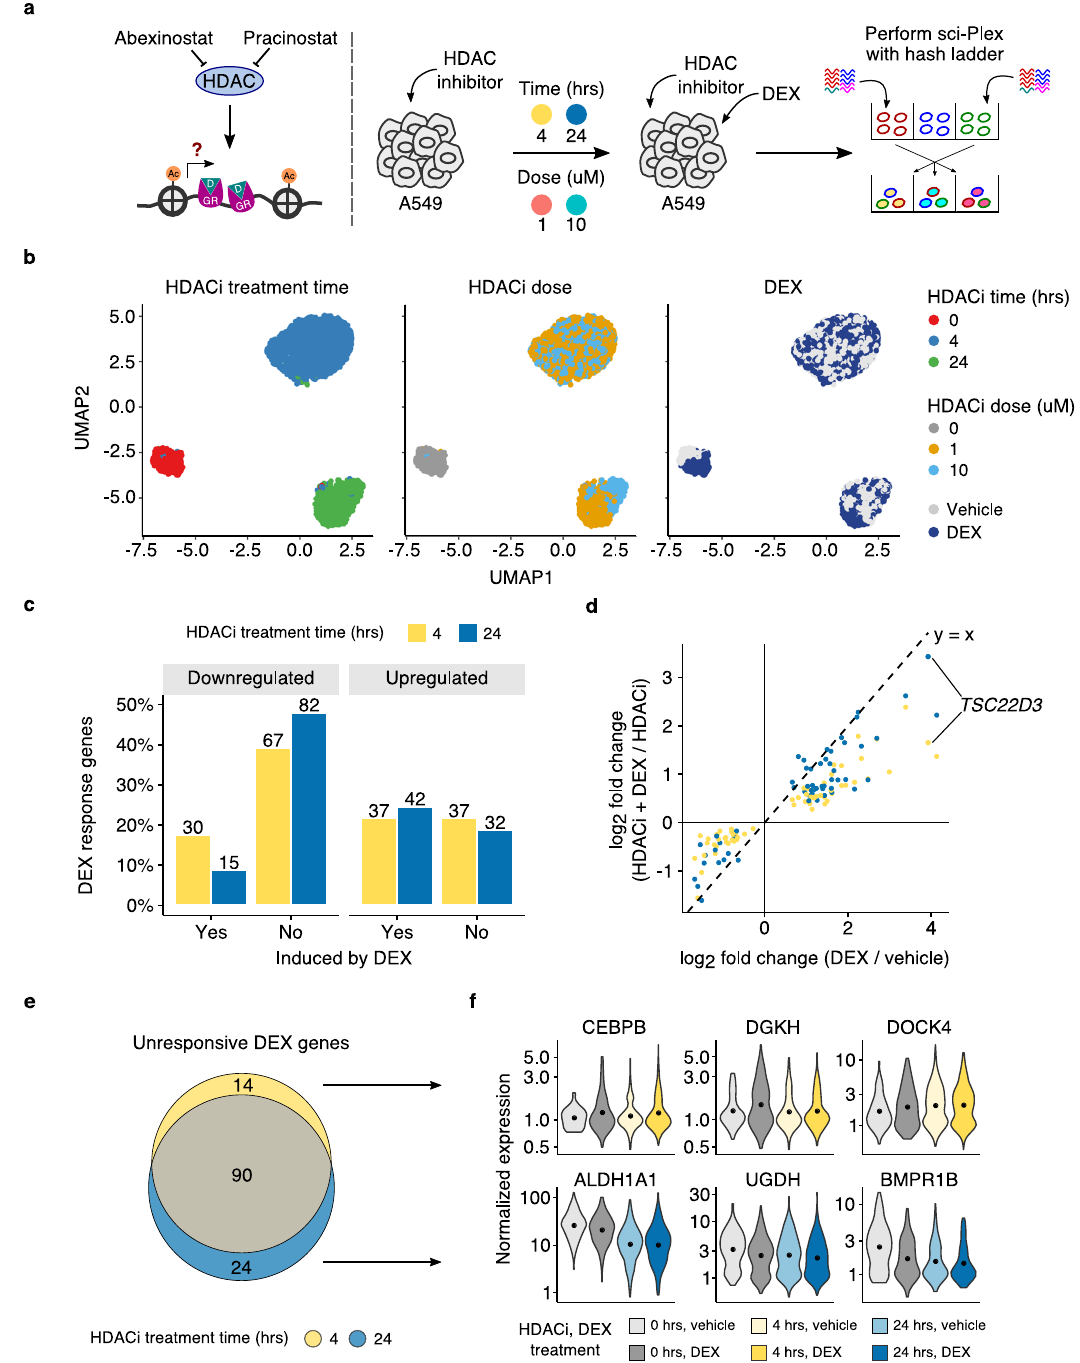
Fig. 4 HDAC inhibition prevents mounting of dexamethasone (DEX) response. a Overview of the experiment. A549 cells were treated with HDAC inhibitors for different periods of time and dose prior to two hour DEX treatment. These cells were subjected to sci-Plex with the addition of the hash ladder. b UMAP projections of vehicle- and DEX- treated A549 cells ( n = 3710 cells over two replicates) in the absence and presence of HDAC inhibitors using the hash ladder normalized expression values. c Percentage of DEX response genes that do not respond to DEX treatment with prior HDAC inhibitor treatment. d Scatter plot comparing log2 fold changes of DEX responsive genes (DEX/vehicle) without and with preceding HDAC inhibitor treatment. Colors respond to the duration of HDAC inhibitor treatment. e Venn diagram of genes that do not respond to DEX at different HDAC inhibitor treatment times. f Hash ladder normalized expression of DEX genes that do not respond in cells that received 4 h (top) and 24 h preceding HDAC inhibitor treatment